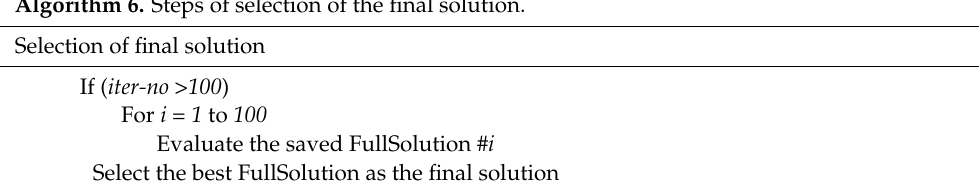
Algorithm 6. Steps of selection of the final